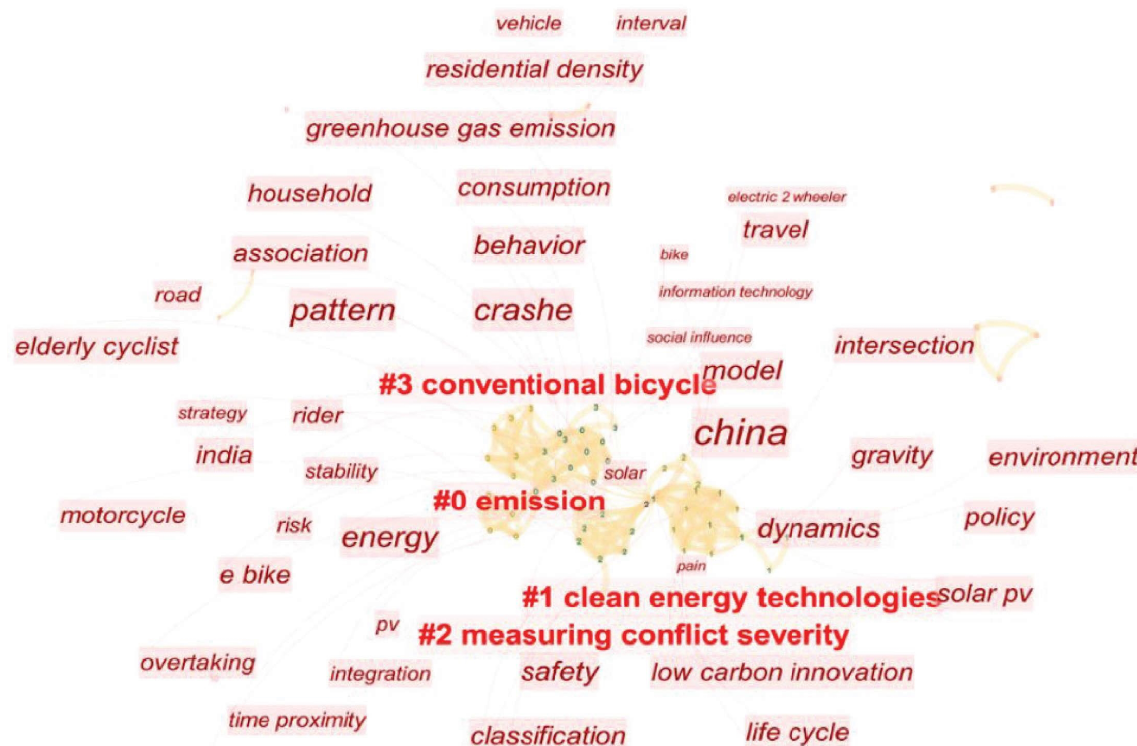
Figure 5: Clustering of research topics on electric